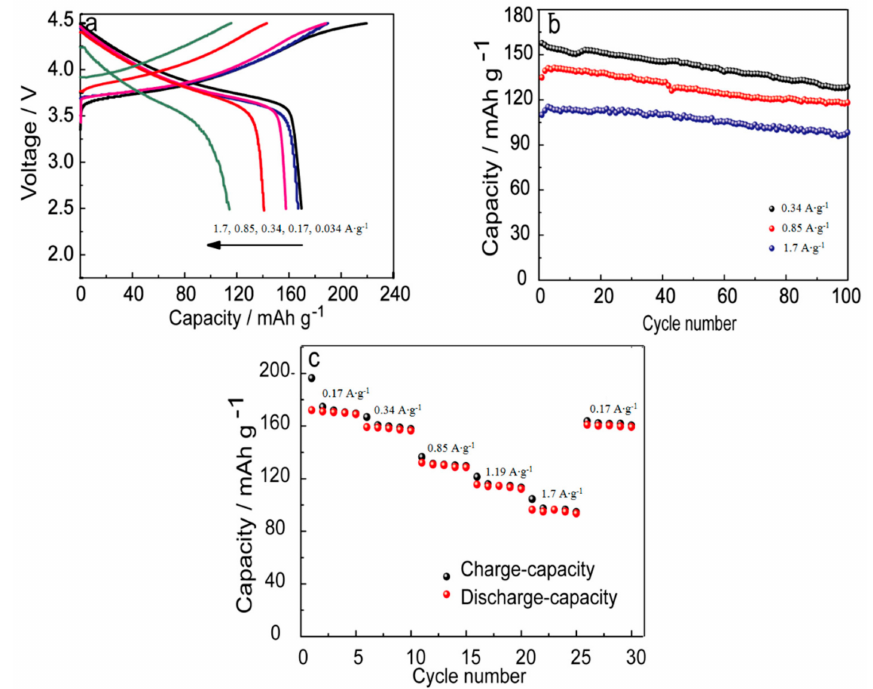
Figure 9. Charge and discharge characteristics of LNCM-1: ( a ) Charge-discharge curve at 0.034, 0.17, 0.34, 0.85 and 1.7 A · g − 1 in the voltage range of 2.5~4.5 V, ( b ) cycle performance at 0.34, 0.85 and 1.7 A · g − 1 in the voltage range of 2.5~4.5 V, ( c ) rate